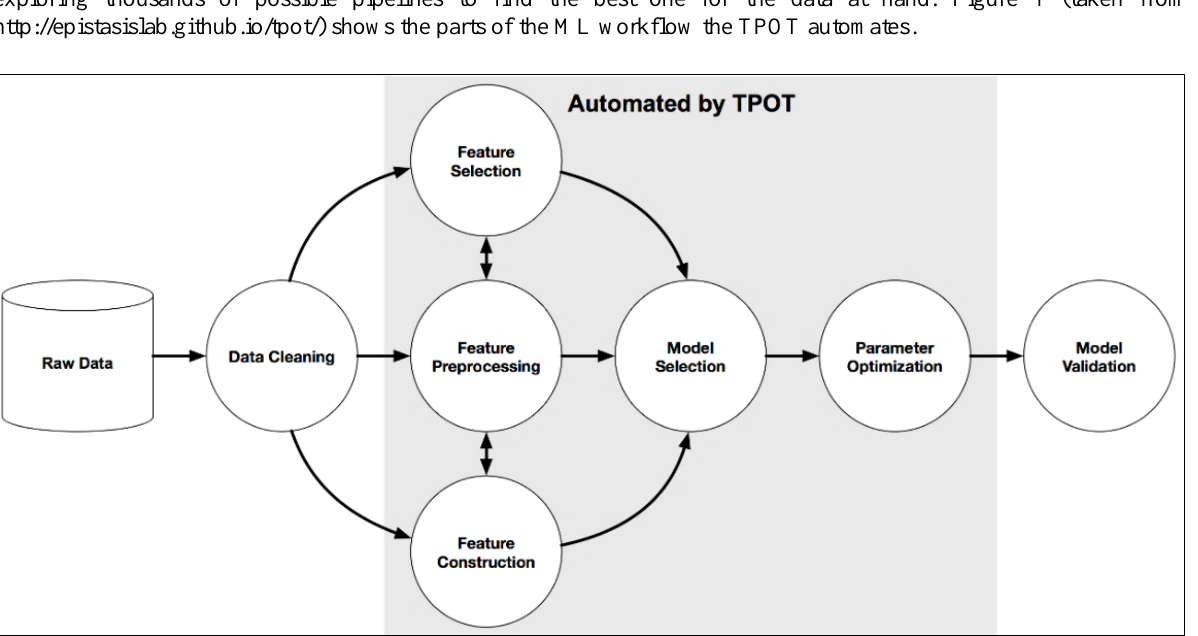
Figure 1. The ML pipeline automated by